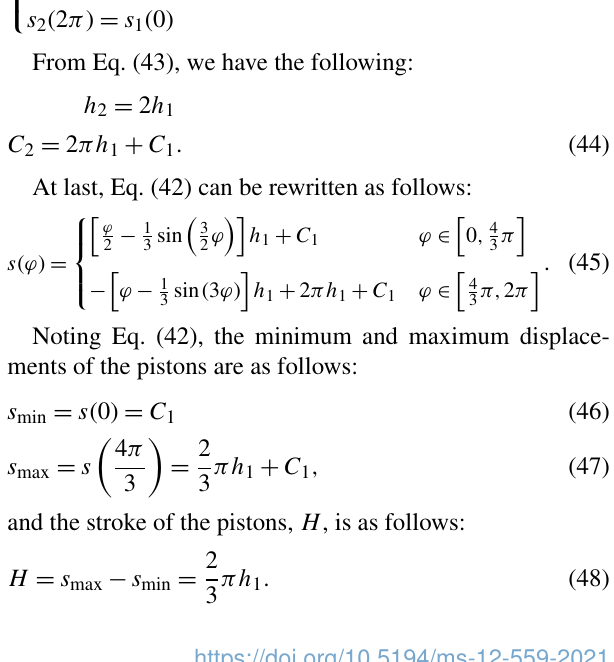
Figure 12. The profile of cam B in three sizes.